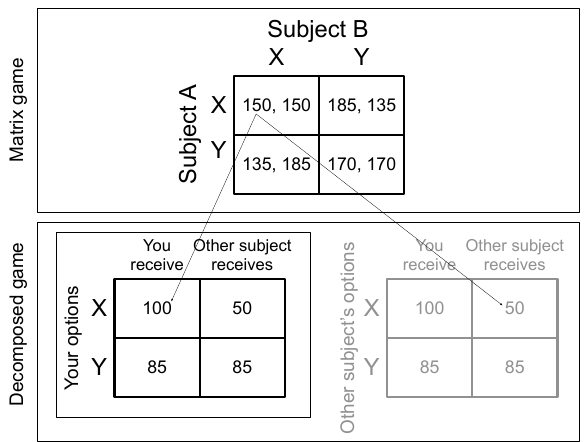
Figure 2. Decomposed game and matrix game. In the matrix game, subject A chooses a row and subject B simultaneously chooses a column. In the decomposed game, both subjects simultaneously choose an allocation and the final payoffs are given by the sum of the allocations. Please note that the only characteristic that differentiates between a decomposed game and a corresponding matrix game is the way information is displayed to subjects while the situation itself is identical in both settings. Since choosing option Y increases the sum of payoffs, the game is a prisoner’s